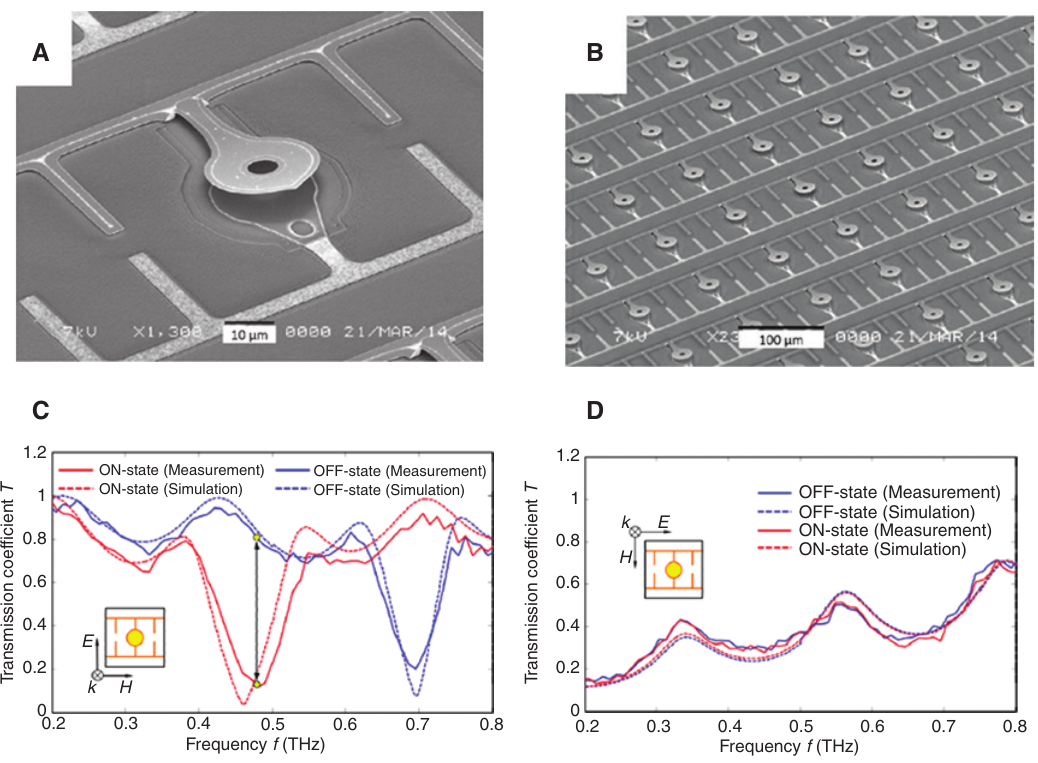
Figure 5: (A and B) MEMS SRR SEM images. (C) THz measured and simulated transmission characterization for incident E-field polar- ized along the cantilever in the off and on positions. (D) Similar characterization for E-field polarization perpendicular to the cantilever. Reprinted and adapted with permission from Han et al. [60],